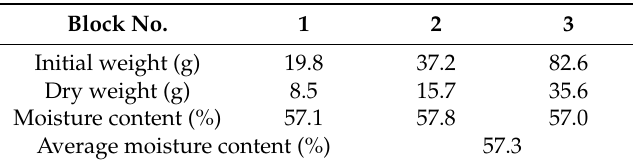
Table 2. Moisture content in natural